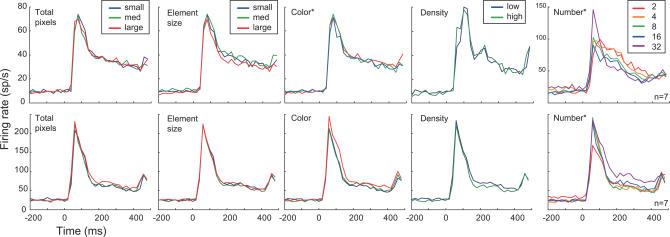
Numerical Sensitivity in LIP Does Not Reflect Low-Level Stimulus AttributesFor 14 of the 31 number-sensitive neurons, stimuli that balanced total number of pixels, individual element size, color, or array density were all interleaved throughout each experiment. The top row shows responses for seven neurons that preferred small numerosities, and the bottom row shows responses for seven neurons that preferred large numerosities. In each panel, trials are divided according to one stimulus attribute only. Firing rate was calculated and then plotted in 20-ms bins.